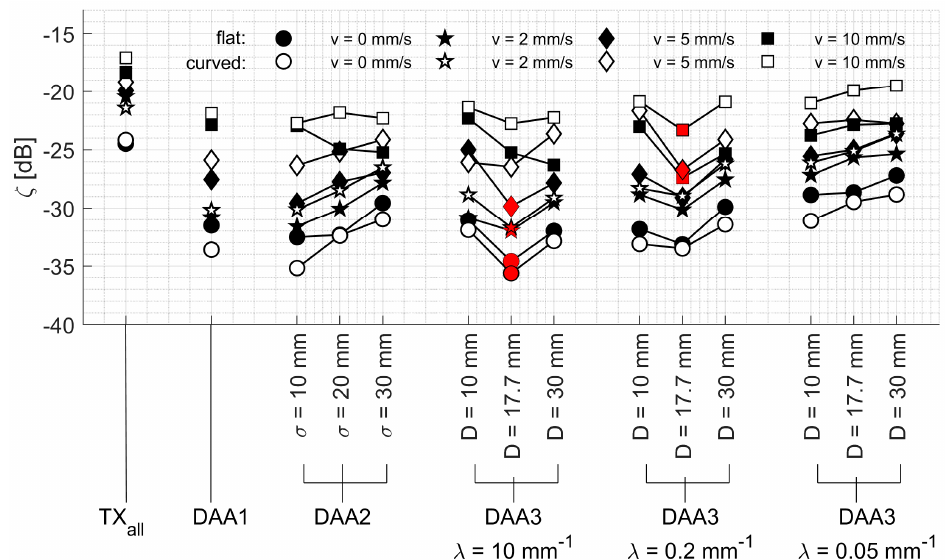
Figure 10. Cost function (Equation (7)) relating the measured SNR to the total transmission power. The black and white color corresponds to the flat and curved array, respectively, and the different symbols correspond to the different velocities with which the experiments were performed. For each experiment, the method which has the lowest cost function is highlighted in red.